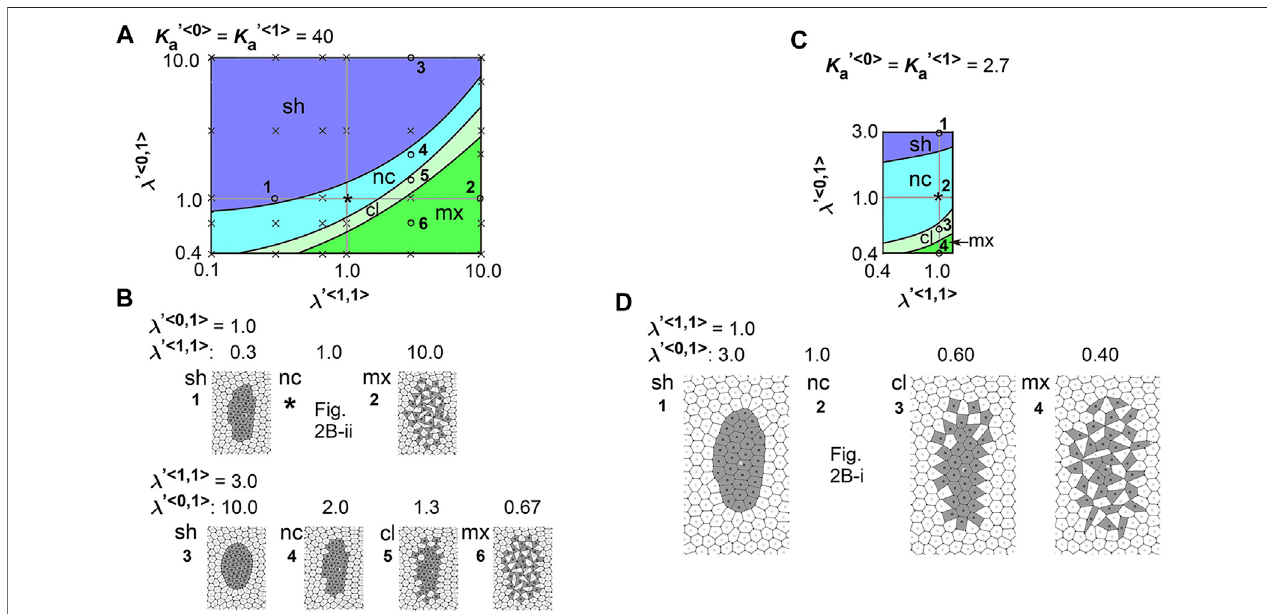
FIGURE 3 | Difference in cell – cell adhesion does not cause elongation of cell cluster on expanding fi eld. Simulations were performed using various line tension values, whereas the area elasticity and coef fi cient of friction were assigned the same values between the two cell types: λ < 0 , 0 > ≠ λ < 1 , 1 > ≠ λ < 0 , 1 > , whereas K < 0 > a K < 1 > a and γ < 0 > (cid:1) γ < 1 > . The fi elds were expanded by three times in area. Phase diagrams and examples of simulation outcomes were shown under K ′ < 0 > a